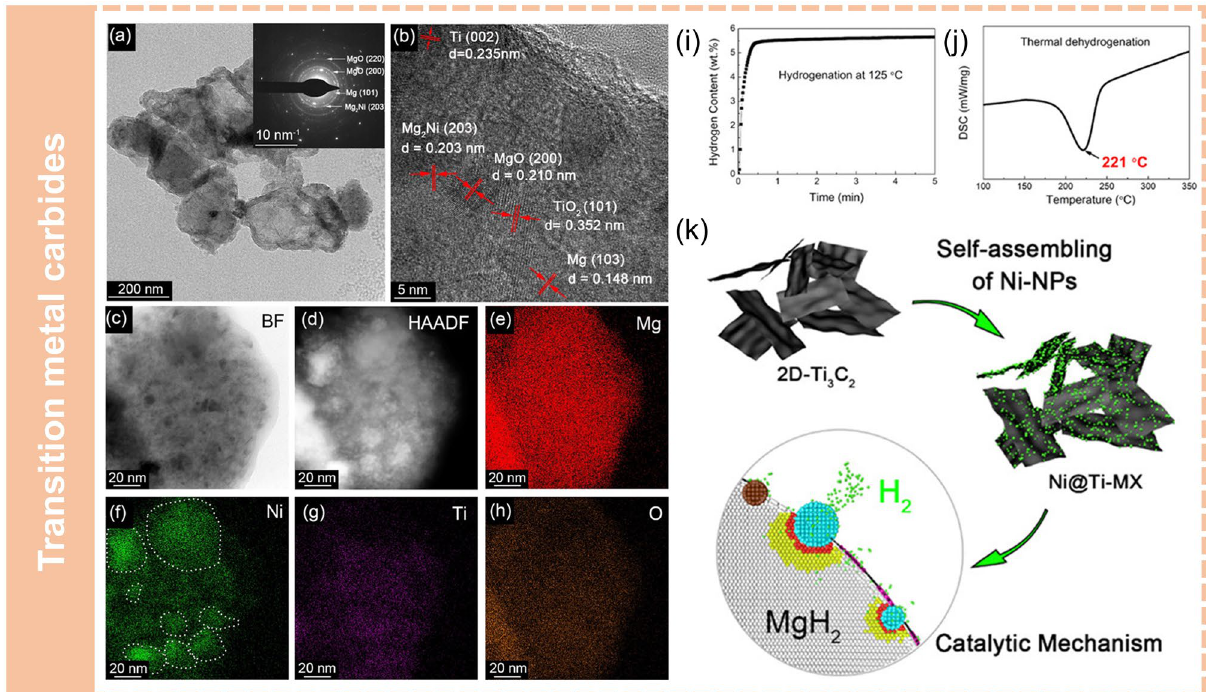
Fig. 7 Synthesis of nanostructured Mg-based composites via mechanical milling. a BF-TEM image and the corresponding SAED pattern (inset). b HRTEM image, and c–h EDS mapping of the dehydrogenated MgH 2 + Ni@Ti-MX composite. i Isothermal absorption curve of MgH 2 + Ni@Ti-MX at 125 °C. j DSC profiles of MgH 2 + Ni@Ti-MX at a heating rate of 3 °C min −1 . k Schematic illustrations of the synthesis process of Ni@Ti-MX and the proposed mechanism for fast hydrogen ab/de-sorption of MgH 2 + Ni@Ti-MX system. Reproduced with